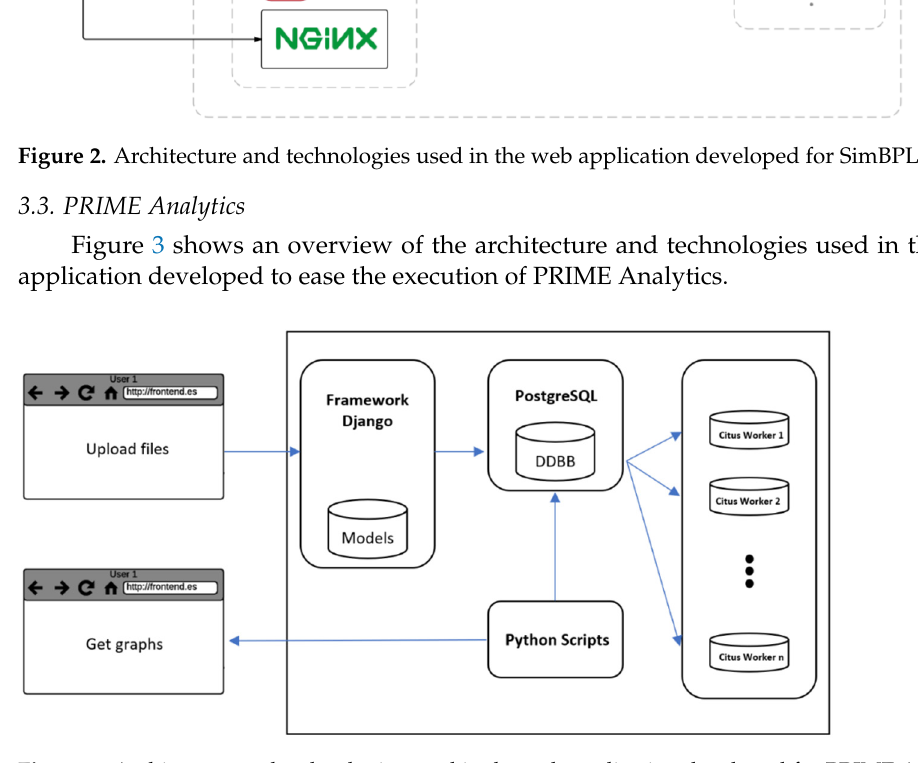
Figure 3. Architecture and technologies used in the web application developed for PRIME Analyt- ics.